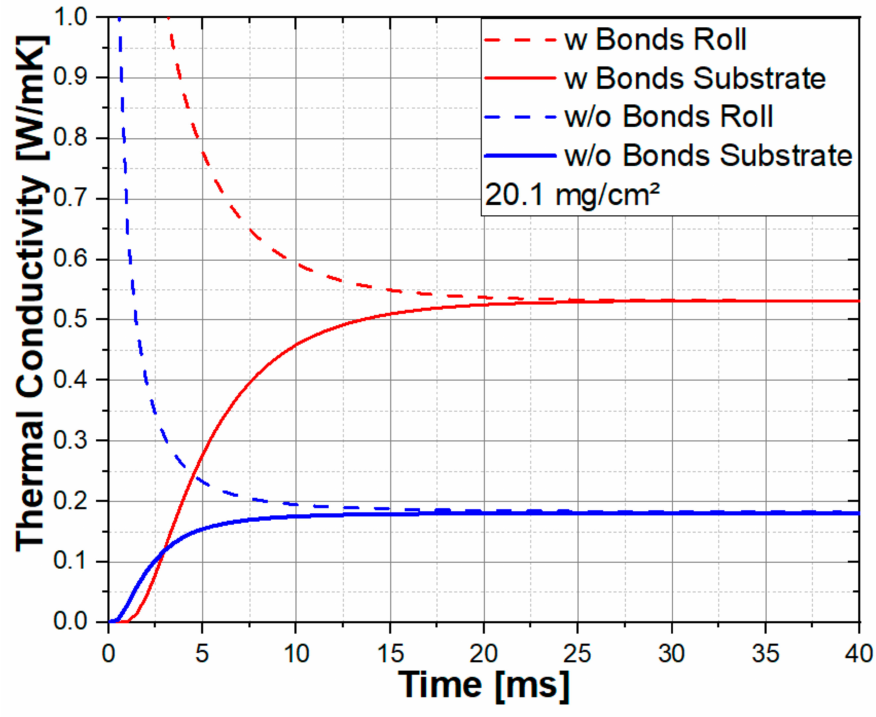
Figure 4. Comparison of the heating behavior of compressed electrodes using the old (without bonds) and the new (with bonds)